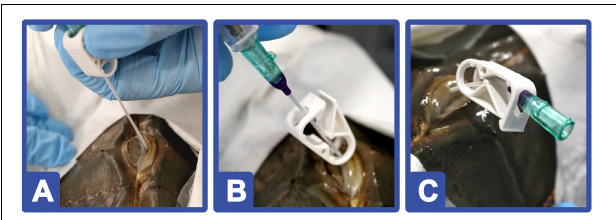
FIGURE 4 | HSC catheter implantation: (A) An 18-gauge needle on an intravascular catheter is inserted into the pericardial membrane toward the prosoma. (B) Once hemolymph was observed in the catheter tubing, a guidewire was deployed. (C) After the catheter was positioned, the needle was retracted; the insertion site cleaned; and a topical adhesive applied. HSCs ( n = 12) were monitored in a “hospital” tank for 7 days before returning to the RAS.